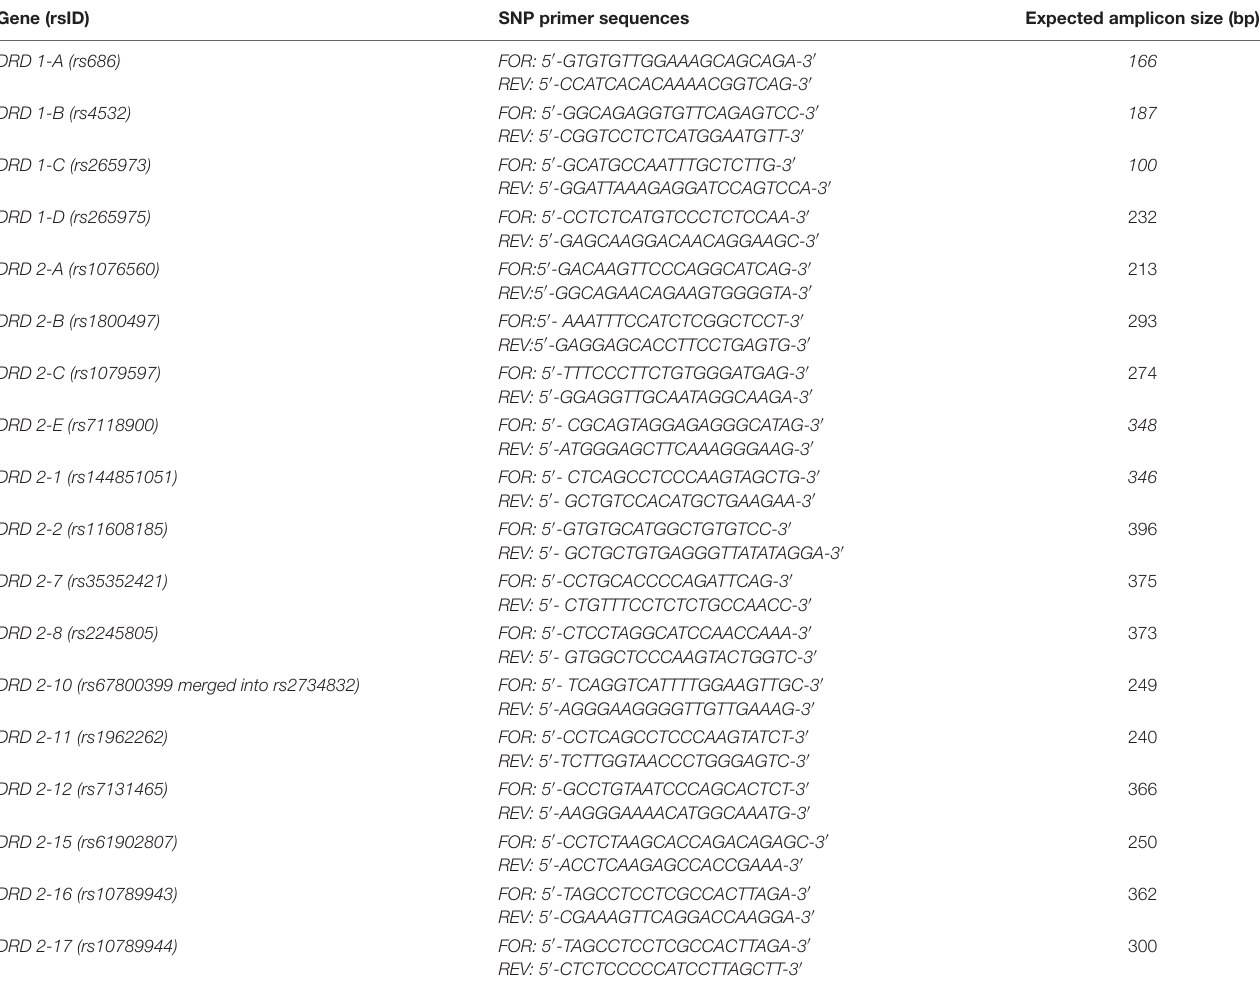
TABLE 1 | List of analyzed polymorphisms of DRD1 and DRD2 genes and of the primer sequences with the expected amplicon size. Gene (rsID) SNP primer sequences Expected amplicon size